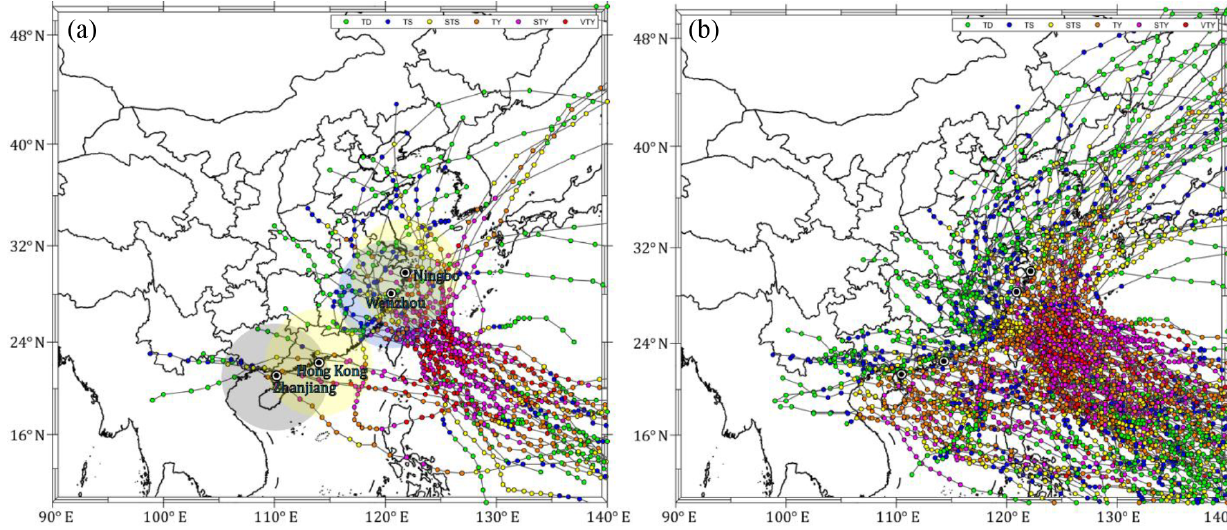
Figure 17. Strong typhoon tracks affect Ningbo, Wenzhou, Hong Kong and Zhanjiang: (a) violent typhoons ( P c < 935hPa or V max > 57ms − 1 ); (b) strong typhoons ( P c < 960hPa or V max > 43ms − 1